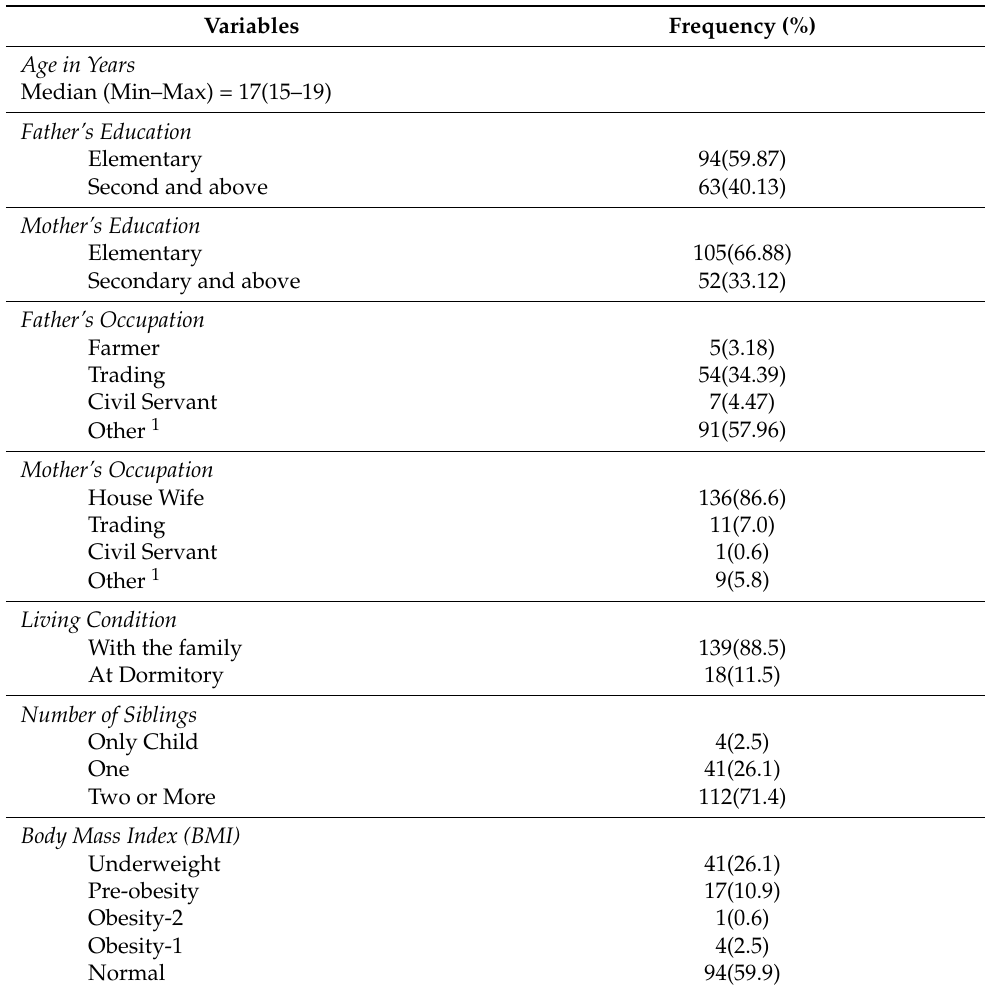
Table 1. Sociodemographic